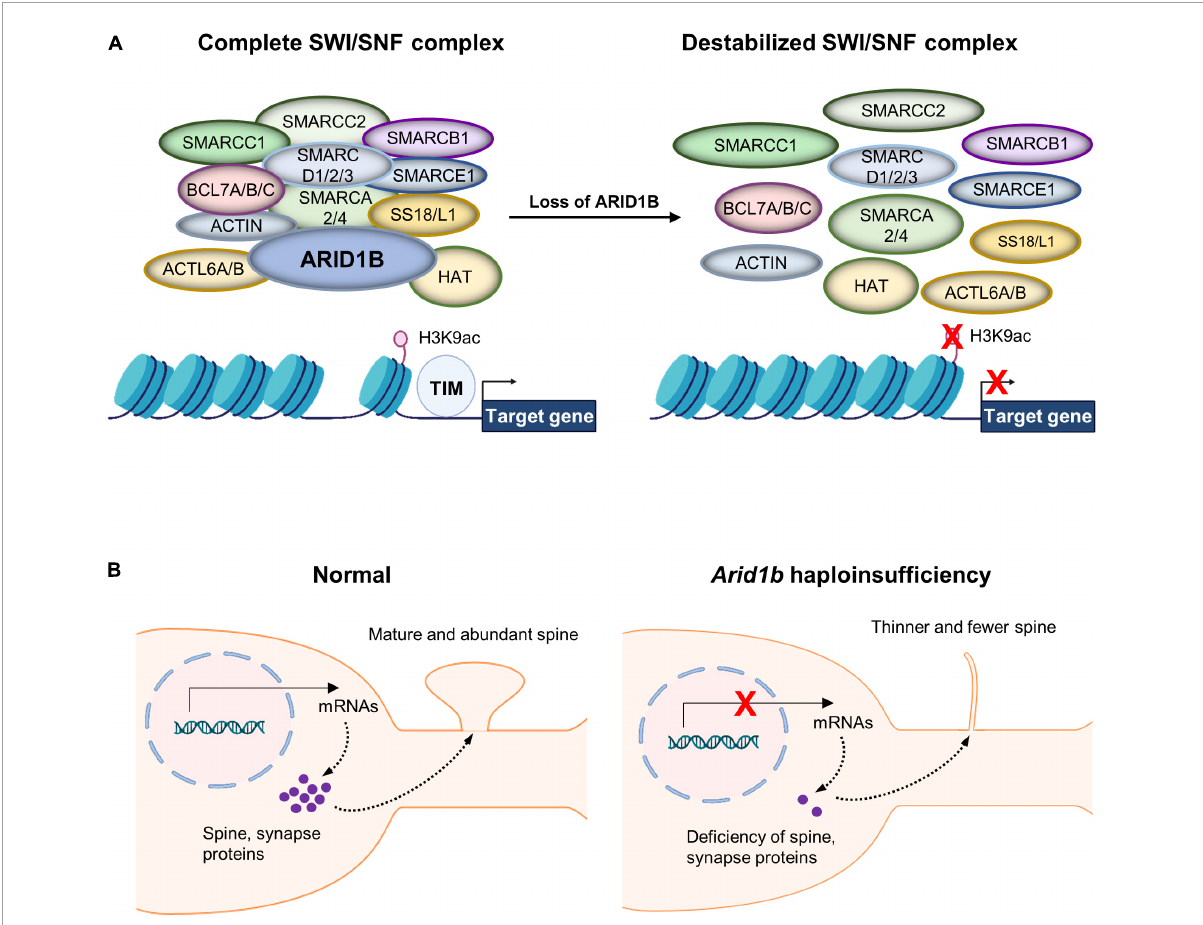
FIGURE1 Chromatin remodeling by the BRG1/BRM-associated factor (BAF) complex. (A) AT-Rich Interactive Domain 1B (ARID1B) acts as a scaffolding protein that holds together the BAF complex, giving it the ability to interact with chromatin. Without ARID1B, the complex is destabilized and therefore unlikely to remodel chromatin correctly. The BAF complex regulates nuclear gene transcription by remodeling a chromatin structure that contains its target genes. The complex performs histone modifications including acetylation of histone H3 at lysine 9 (H3K9ac). Thereby, chromatin detangles and exposes naked gene areas to the transcription initiation machinery (TIM). Multiple enzymes are collectively involved in the histone modification at the regulatory regions of their target genes. Although histone H3 trimethylation at lysine 4 (H3K4me3) is also impacted by the BAF complex as well as histone H3 trimethylation at lysine 27 (H3K27me3), they are not featured in this specific example. (B) Normal neurons express spine and synaptic proteins that move to synaptic compartments and direct synaptic maturation. However, Arid1b haploinsufficient neurons lack proper expression of synapse-associated genes, leading to underdeveloped dendritic